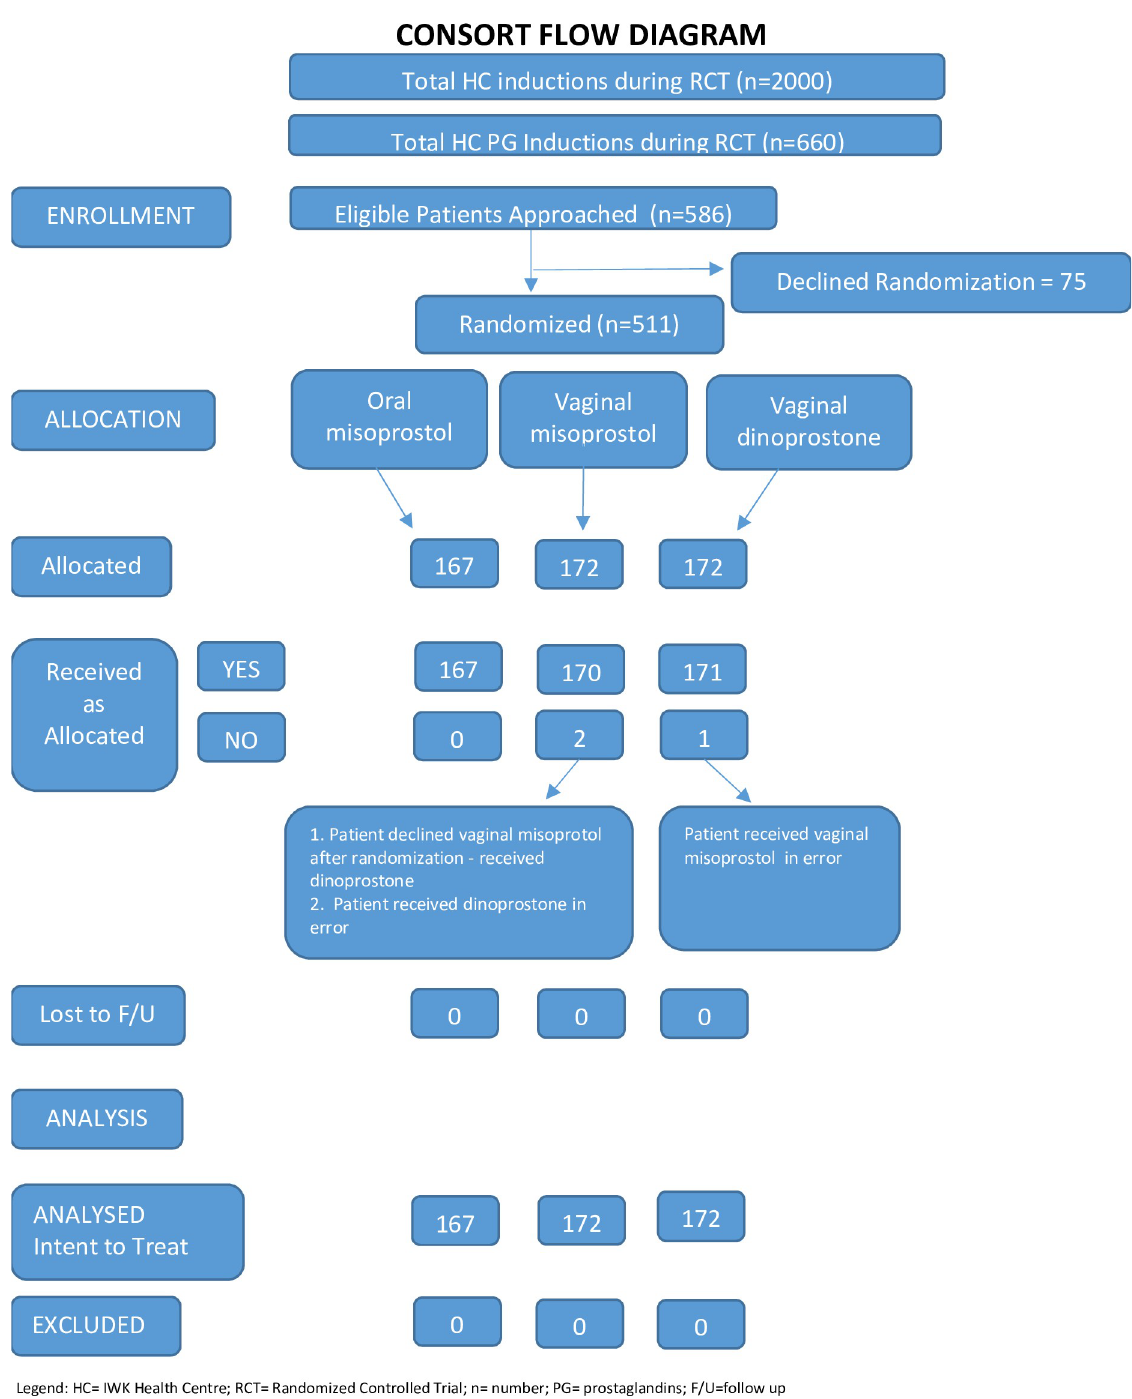
Fig 1. Consort flow diagram. HC = IWK Health Centre; RCT = Randomized Controlled Trial; n = number; PG = prostaglandins; CS = cesarean section (all low transverse). Two women with twins (ineligible) were randomized, one to vaginal misoprostol and one to vaginal dinoprostone. Maternal data are included. Only first twin of each pair is included in newborn data, but all four newborns had good outcomes after vaginal birth.